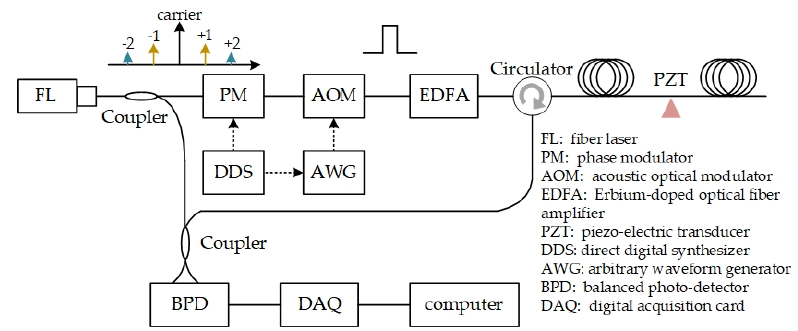
Figure 5. System scheme of Φ -OTDR with frequency diversity. Reproduced from our previous paper [62].